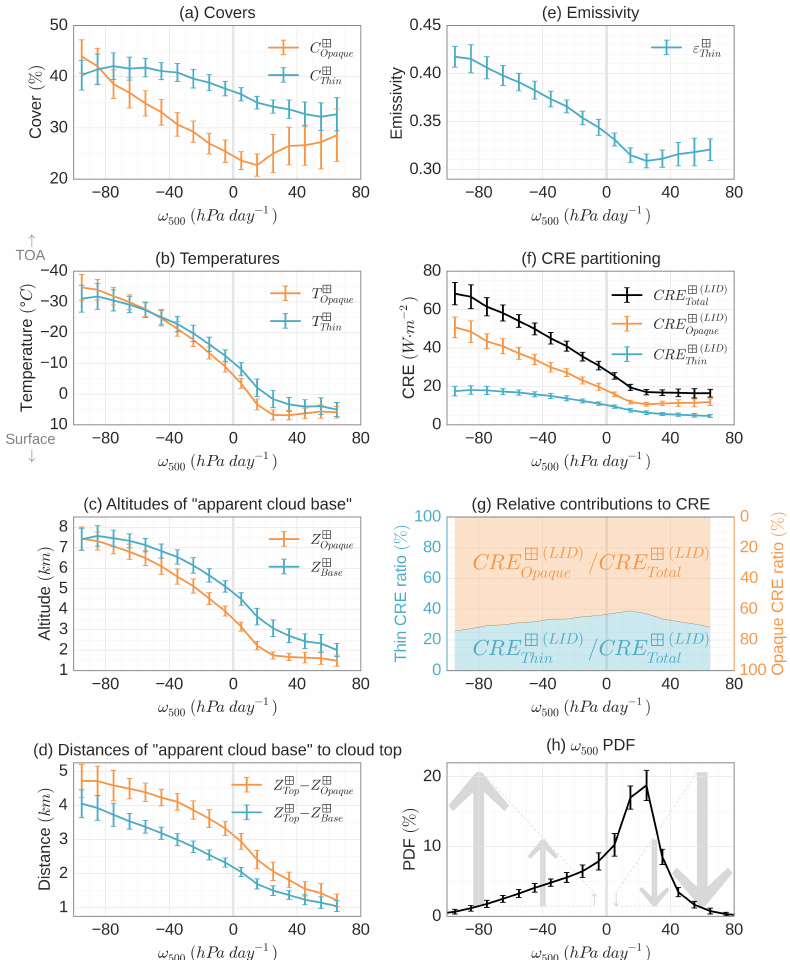
(cid:1) (cid:1) , opaque and C thin (cid:1) (cid:1) − among thin clouds, (d) Z top base